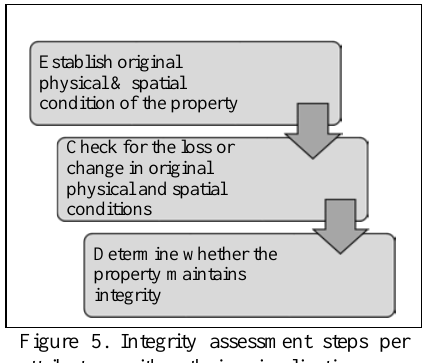
Figure 5. Integrity assessment steps